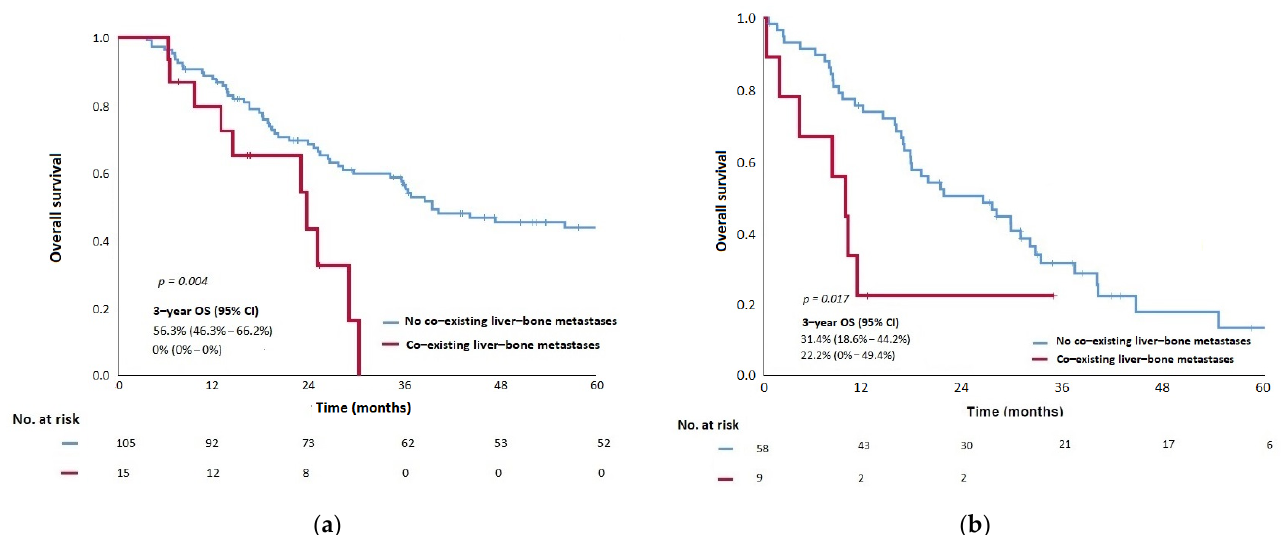
Figure 3. Kaplan–Meier curves showing ( a ) overall survival (OS) of patients of proposed M1a and M1b categories stratified by the presence of co-existing liver-bone metastases in Anatomic-RPA groups derived in Set 1 RPA in the training cohort, ( b ) OS of patients of proposed M1a and M1b categories stratified by the presence of co-existing liver-bone metastases in Anatomic-RPA groups derived in Set 1 RPA in the validation cohort. RPA, Recursive partitioning analysis.